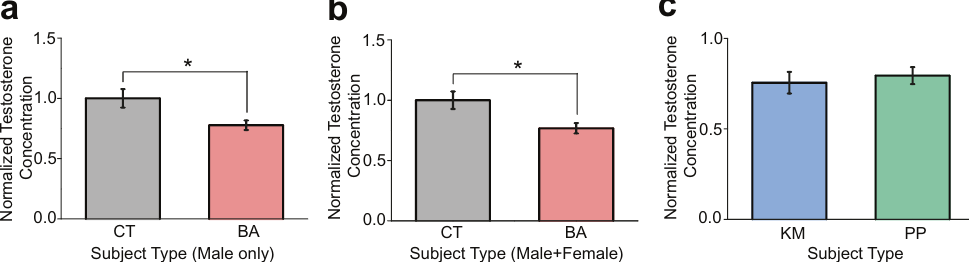
Fig. 4 Blood testosterone concentration assays with ELISA. a Bar graph showing testosterone concentrations in blood samples from male behavioural addiction (BA) patients and control (CT) subjects (top). b A graph similar to (a) but showing BA patients and CT subjects with both male and female subjects combined. c A graph similar to ( a ) but showing KM and PP concentrations did not differ between KM and PP patients (Fig. Basal testosterone concentrations in blood samples obtained 4c). from male BA patients ( n = 9) were signi fi cantly lower than those These results suggest that, consistent with the lack of of male CT subjects ( n = 9; t 16 = − 2.58, p = 0.020; Fig. 4a). Lower heightened aggression in BA patients in the PSAP test, blood testosterone concentrations were retained even when both male testosterone concentrations are comparable or even lower in BA and female samples were combined (BA patients, n = 16; CT patients than in CT subjects. subjects, n = 24; t 38 = − 2.43, p = 0.020; Fig. 4b). Testosterone